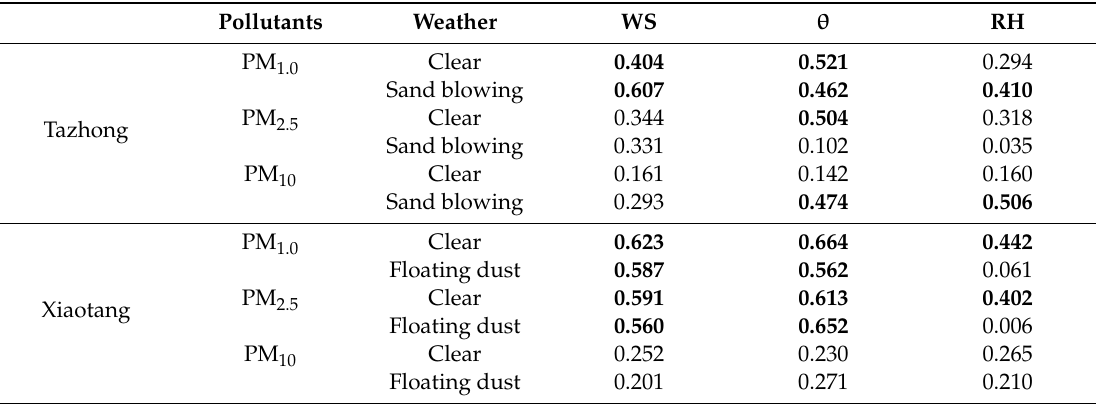
Table 5. Correlation coe ffi cients between the PM concentrations and the various meteorological parameters during clear and dusty periods at Tazhong and Xiaotang (bold values represent those that passed the 95% significance